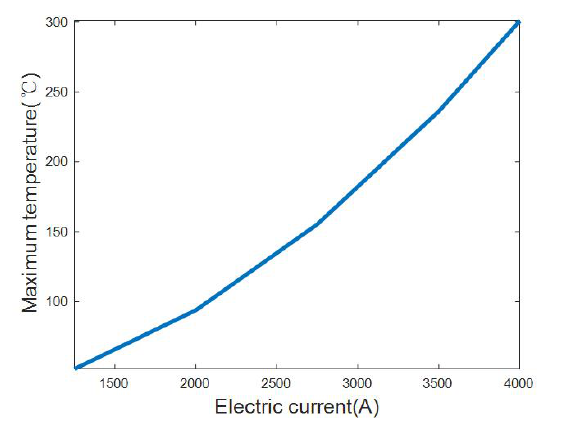
Fig. 5. Temperature distribution of plum blossom contact at rated current 1250A